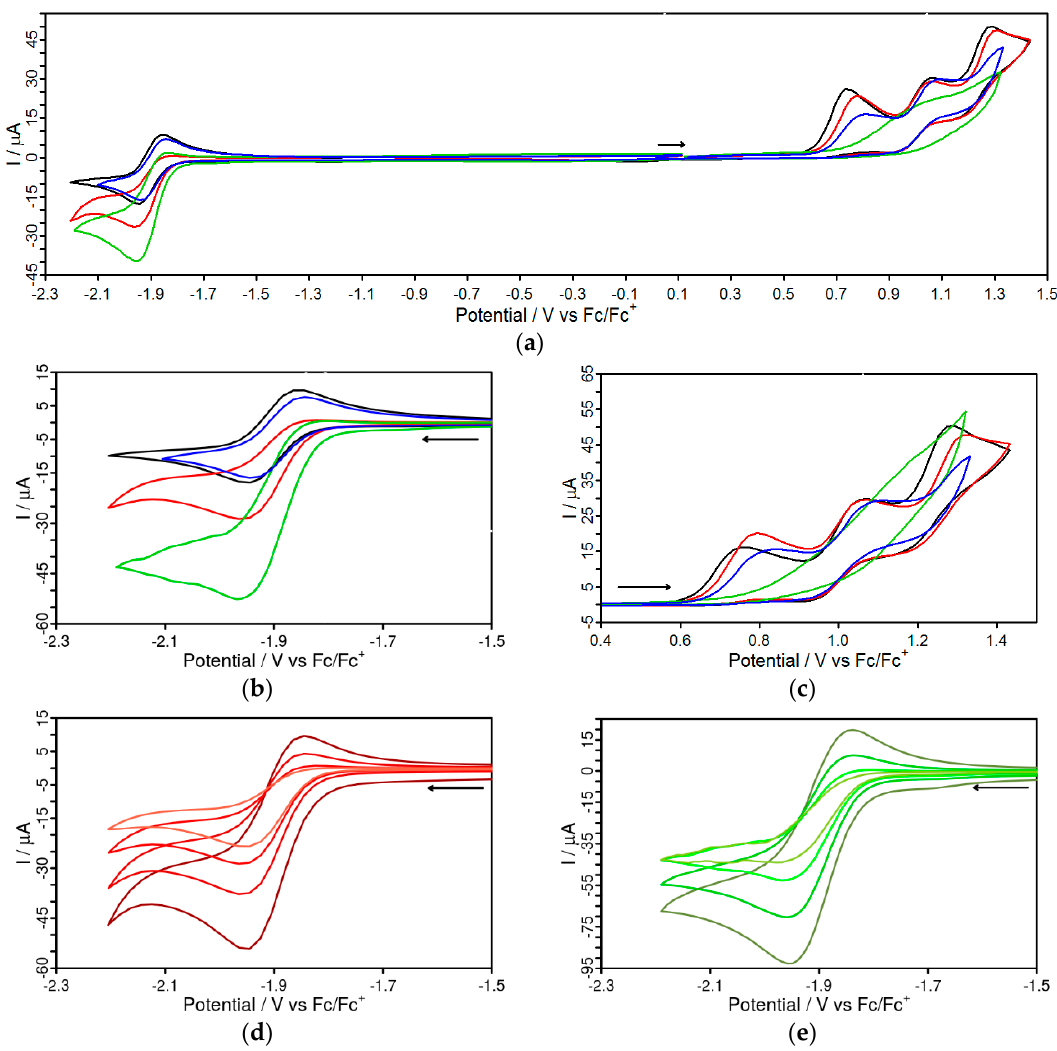
Figure 5. Cyclic voltammograms of C1 (black), C2 (red), C3 (green) and C4 (blue) in acetonitrile solution using TBAPF 6 (0.1 M) as supporting electrolyte. All measurements, if not stated otherwise, were conducted with a scan rate of 100 mV/s. The arrow illustrates the initial scan direction. In ( a ) the full scan is given, while in ( b ) the reduction waves and in ( c ) the oxidation waves were measured separately. In ( d ) the reduction waves of C2 and in ( e ) of C3 are shown with different scan rates of 500 mV/s, 250 mV/s, 100 mV/s, 50 mV/s (for C2 from dark red to light red and C3 from dark green to light green).